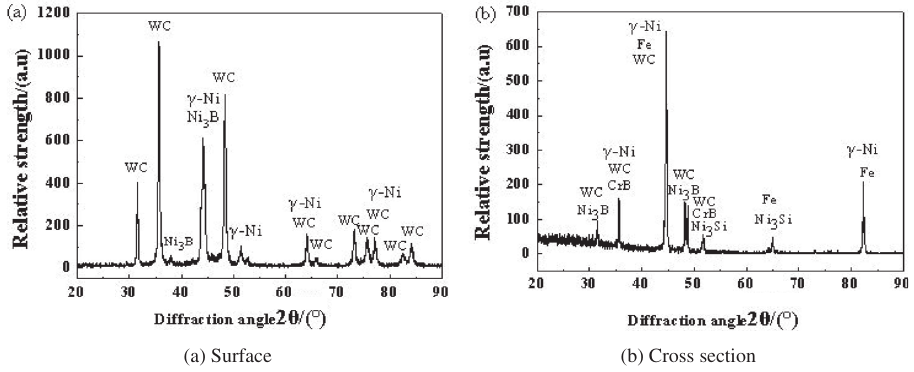
Figure 6: Surface and cross section XRD of 50% WC composite coating:(a) Surface, (b) Cross